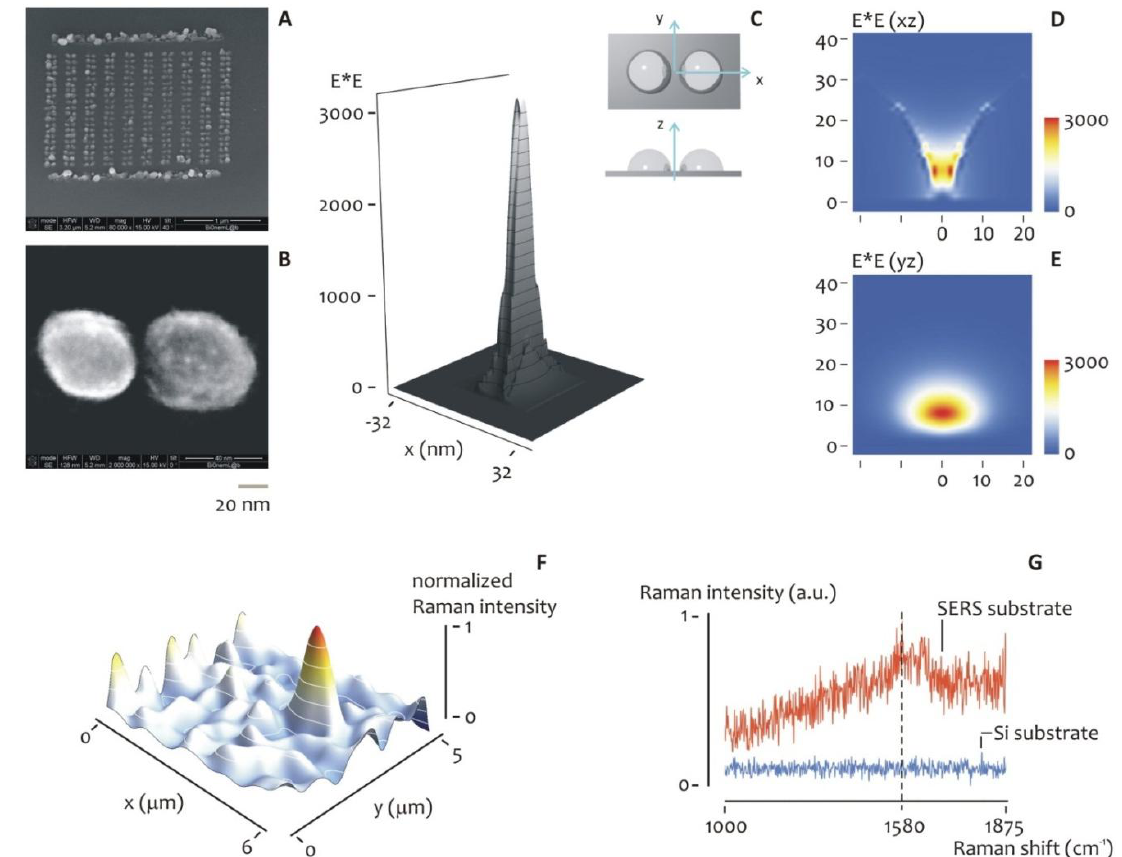
Figure 5. The laws of electroless particle deposition at the nano-scales, revealed in Figure 4, were utilized to fabricate dimers of silvers nano-particles. The low magnification SEM image in ( A ) show the ability of the method of realizing silver dimers of nano-particles on a large scale, where the size and spacing of those spheres is controlled with extreme precision, as revealed by the high magnification SEM image in ( B ). In ( C ), a 3d representation of the field intensity of the electromagnetic field in the plane of the substrate is reproduced, while in ( D , E ) the projection of such a field is reported in the xz and y z planes, where major details are shown, and where it can be noticed how the enhancement in the electrical filed intensity is as large as 10 3 . The detection capabilities of a system of similar dimers were therefore verified using, as a probe, benzenethiol (BT). A 3d Raman intensity map of the sample acquired over a region of interest large 5 × 6 microns is shown in ( G ). ( F ) shows two individual SERS spectra, acquired on the SERS (silver-dimers) substrate and simple silicon, respectively, where the difference in intensity between the two demonstrate the increased efficiency of the array of silver dimers as a SERS